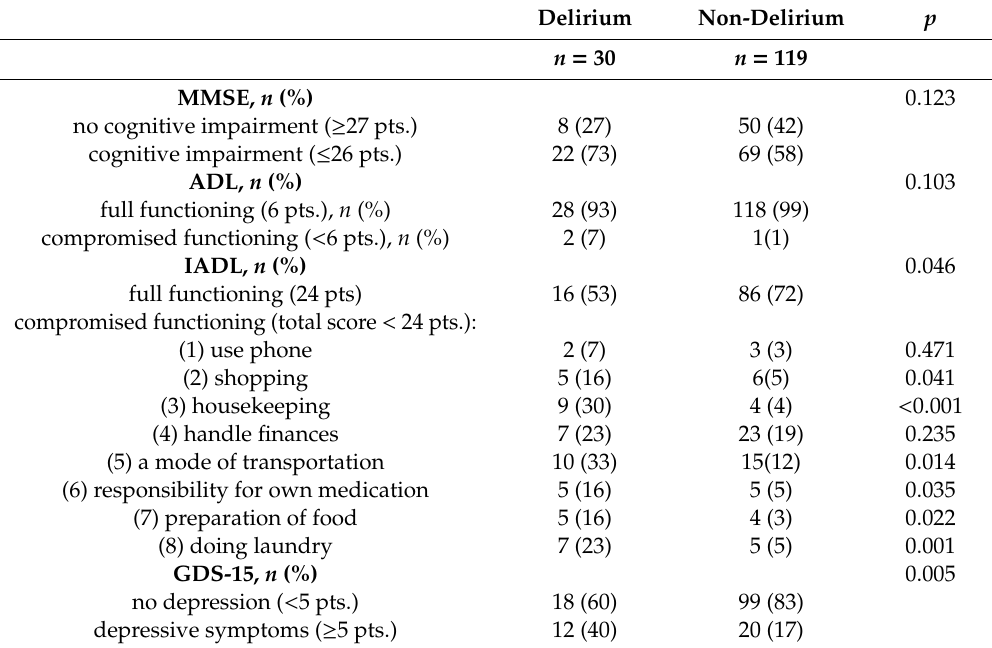
Table 2. Preoperative geriatric assessment: an analysis comparing the assessment of subjects who developed delirium and those who did not.